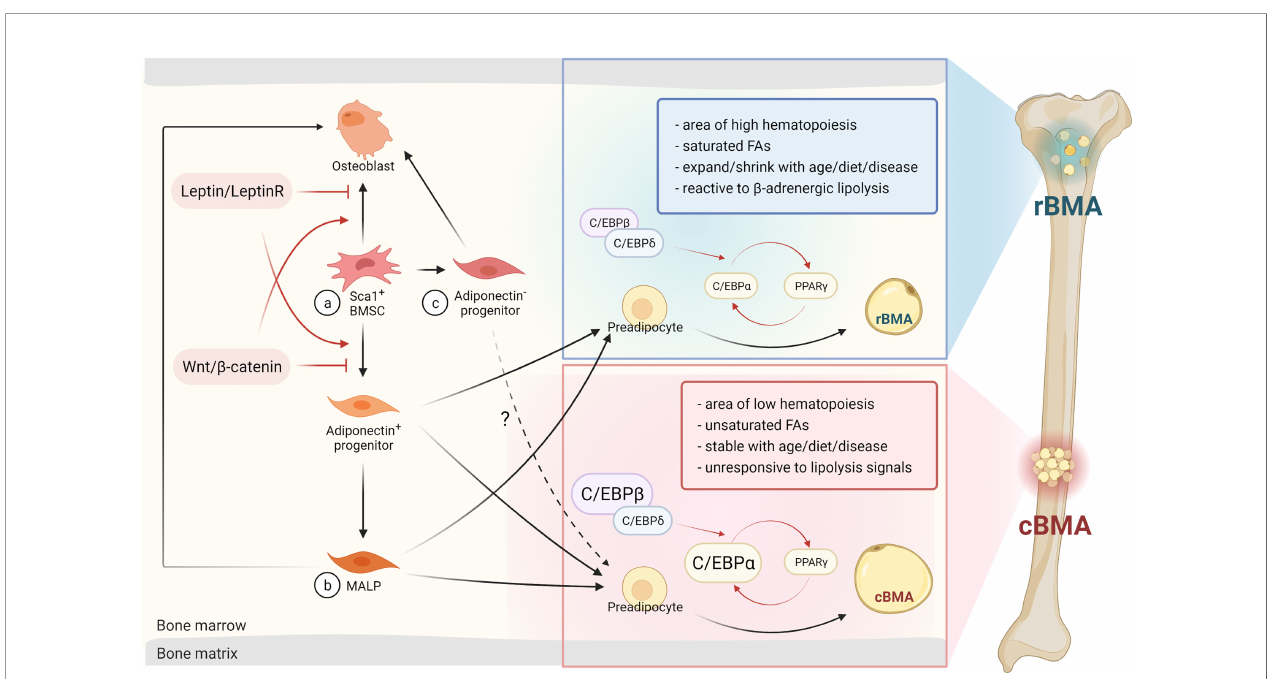
FIGURE 1 | BMAs arise from BMSCs and can differentiate via osteogenic or adipogenic progenitors into rBMAs or cBMAs. (A) BMAs or osteoblasts originate from Sca1 + BMSCs modulated by the Leptin/LeptinR or Wnt/ b -catenin signaling pathways (20 – 23, 35, 36). (B) MALPs are a newly de fi ned primarily adipogenic sub- population that arises from adiponectin + progenitors. Factors like acute injury and aging can trigger osteogenic differentiation of MALPs (30, 31). (C) Adiponectin - progenitors are predominantly of the osteogenic lineage, but are also able to differentiate into BMAs in metabolic disorders or in aging adults. This population elicits similar properties as cBMAs (30). BMSC, bone mesenchymal stem cells; rBMA, regulated bone marrow adipocyte; cBMA, constitutive bone marrow adipocyte; MALP, marrow adipogenic lineage precursor; C/EBP, CCAAT/enhancer-binding protein; FA, fatty acid; PPAR g , peroxisome proliferator-activated receptor gamma. Red arrows indicate transcription factors and signaling pathways. Dark arrows represent the consecutive stage of differentiation. The dashed arrow emphasizes similarities in cBMAs and adiponectin - progenitor-derived BMAs. Designed by